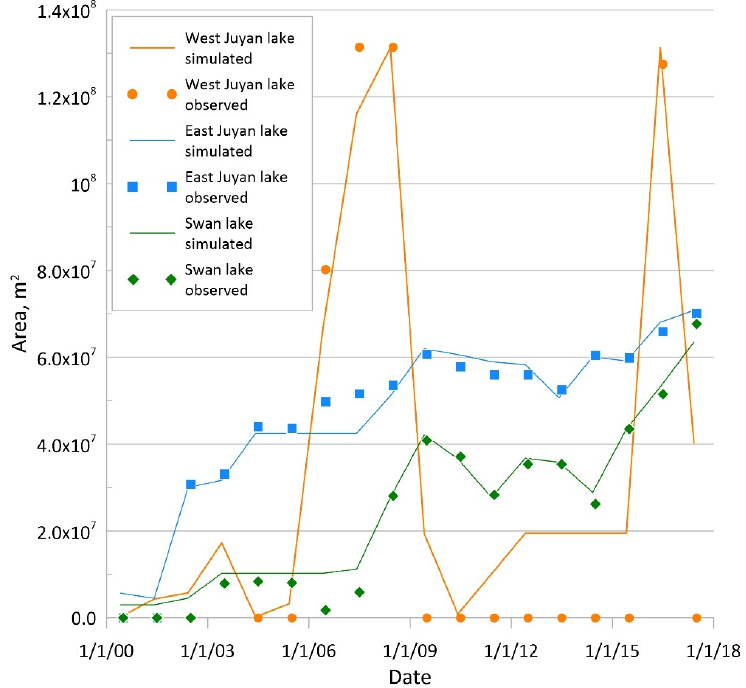
Figure 13. Simulated and observed area dynamics of East Juyan, West Juyan, and Swan Lakes for the period 2000–2017.